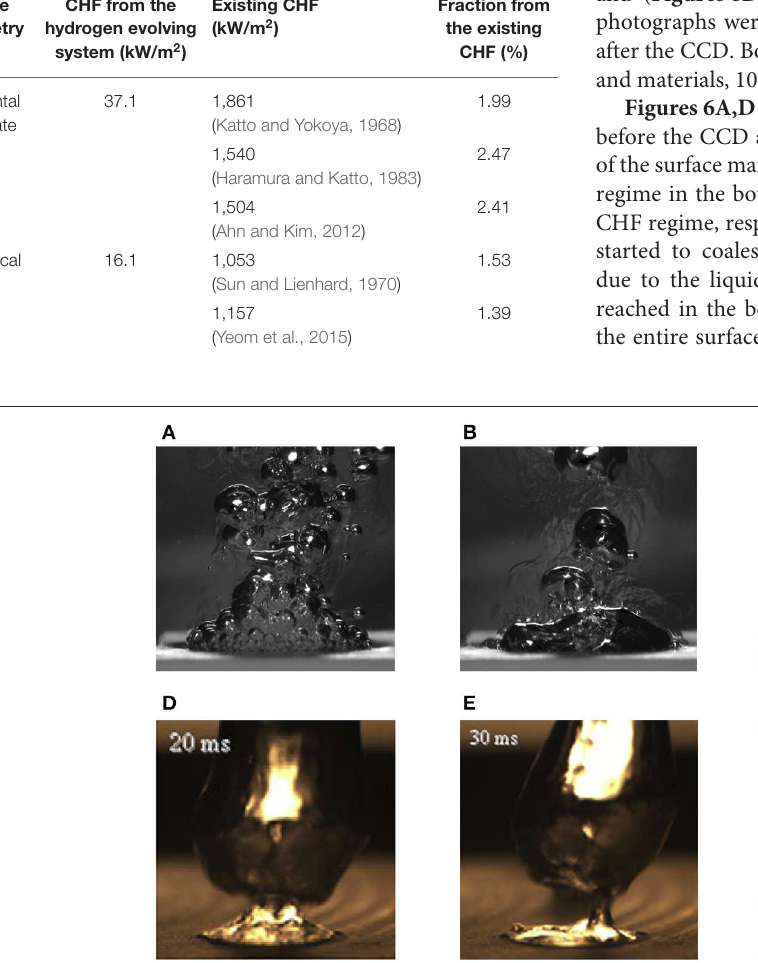
Frontiers in Energy Research |